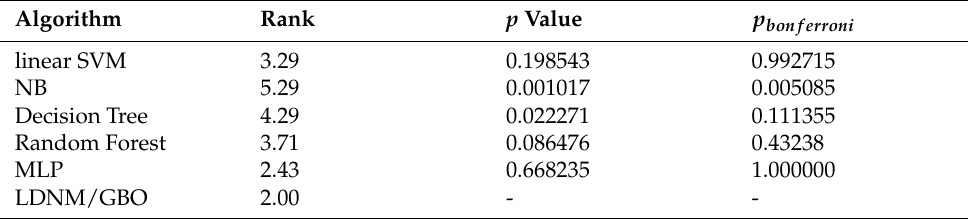
Table 6. Friedman test of the comparison results reported in Table